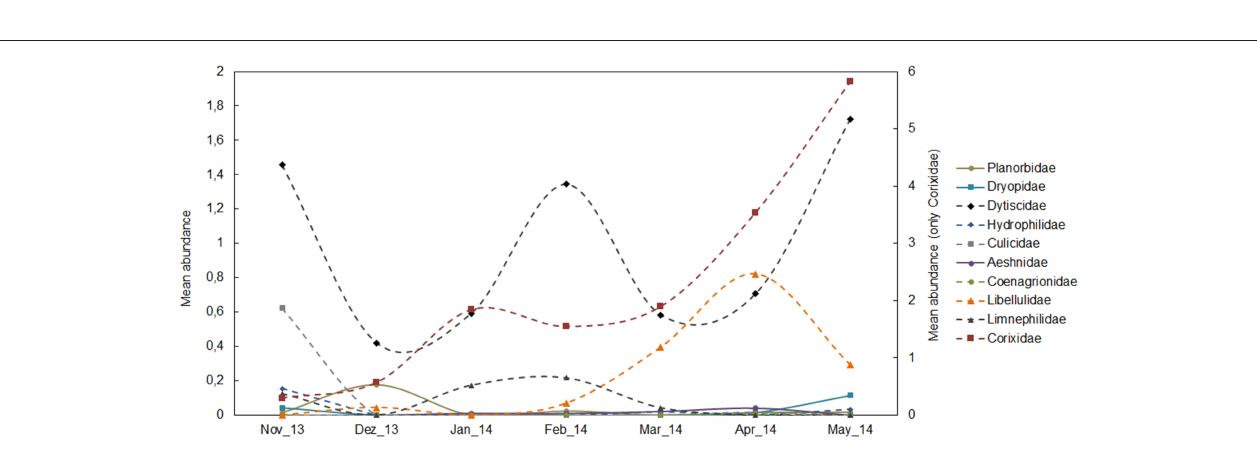
Frontiers in Ecology and Evolution |